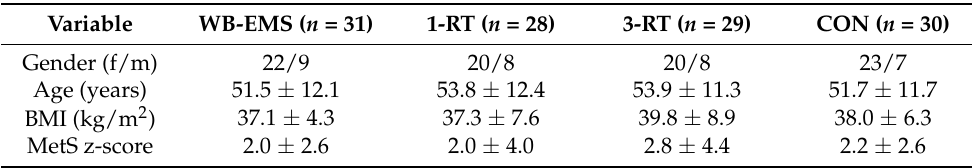
Table 1. Baseline characteristics of all study